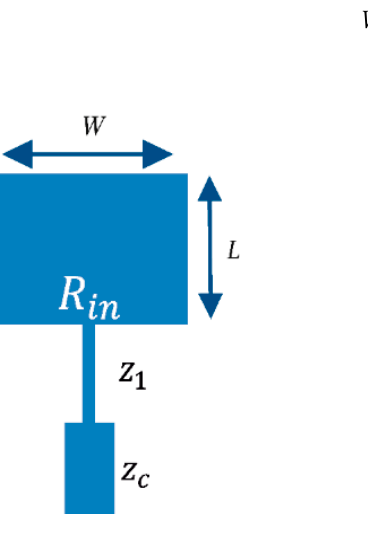
Figure 2. Square patch antenna with quarter-wave coupling length.